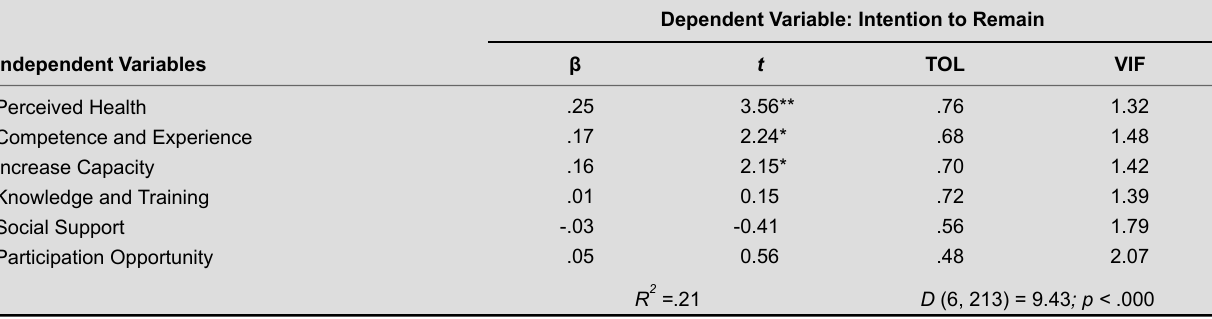
Dependent Variable: Intention to Remain VIFTOL t βIndependent Variables